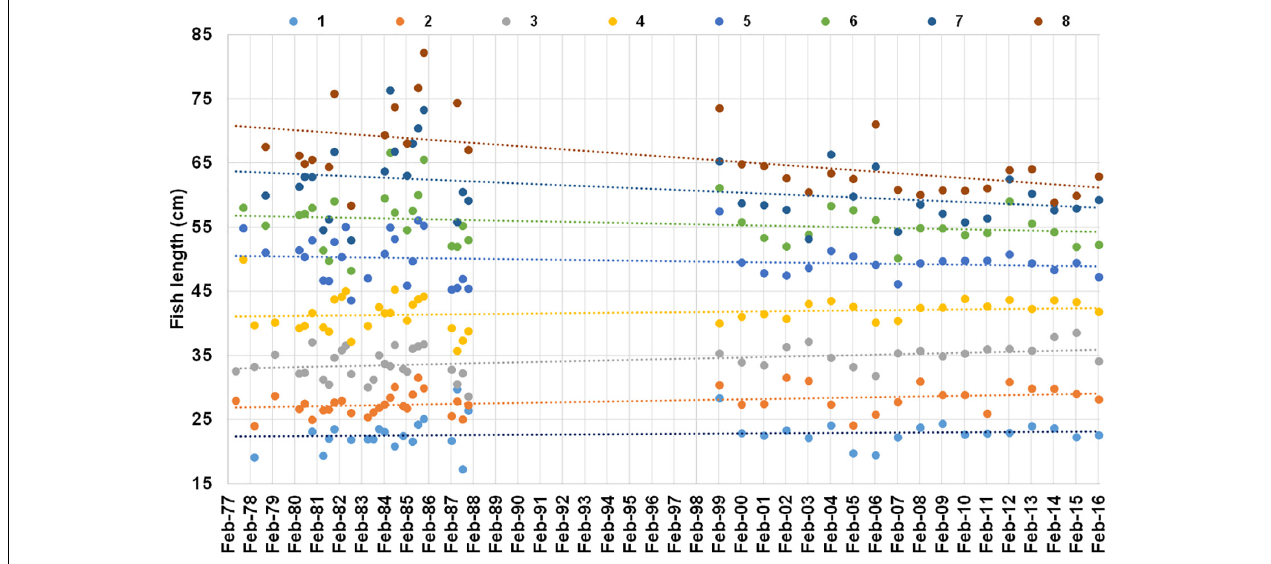
Table S1 ). Linear regression lines of mean length-at-age against date of capture are shown in the same color as the dots for each age (all regression outputs are shown in Table 4